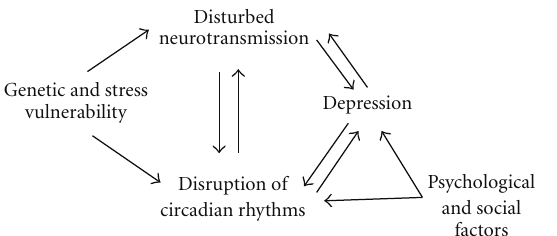
Figure 1: Potential model of depression. The reciprocal relationship between the disruption of circadian rhythms and behavioral disorders may be either cause or e ff ect of a depressed a ff ective state, and it is influenced by genetic, neurochemical, and neuroendocrine factors